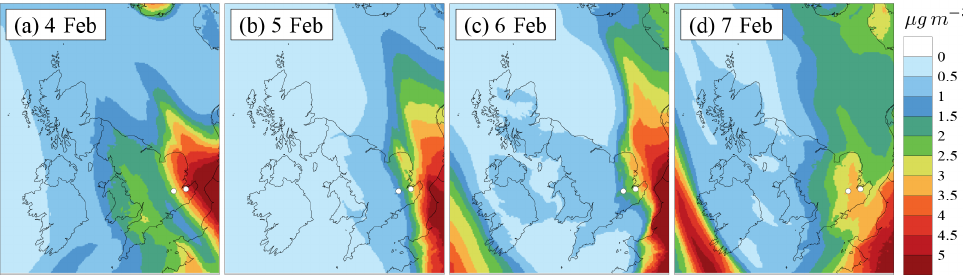
Figure 15. Modelled (addDiesel experiment) daily average concentrations of SOA during the second SOA episode of the winter 2012 IOP. The white circles mark the measurement site locations – left: London North Kensington; right: Detling.